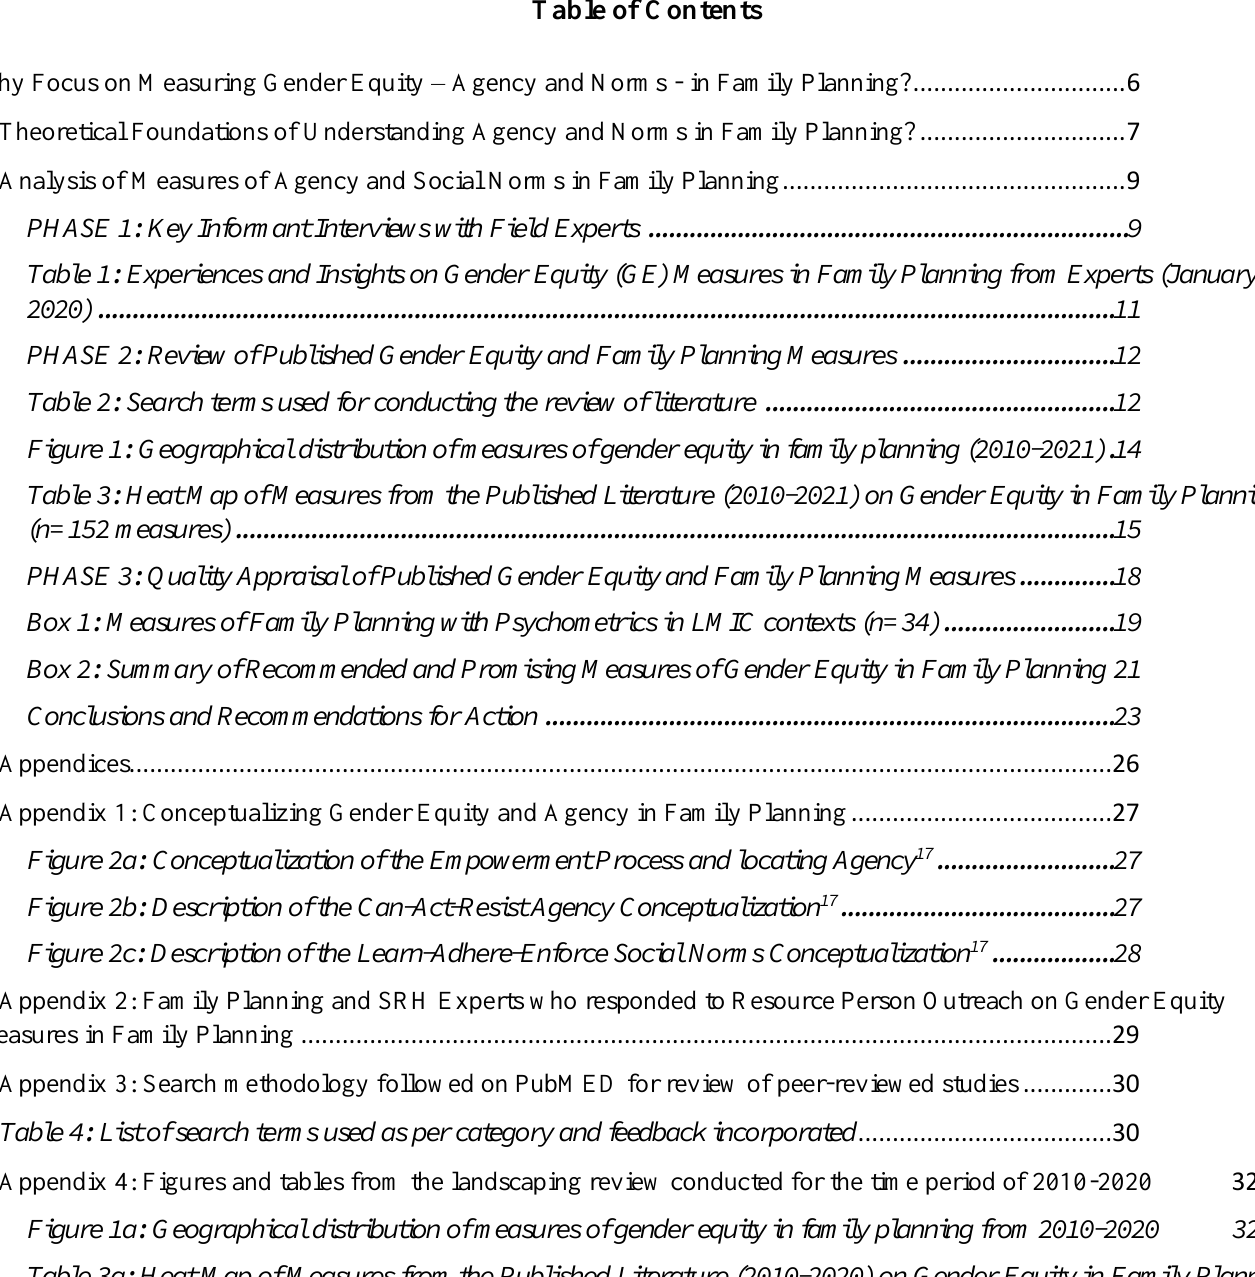
Table 5: Full list of gender equity measures in family planning in the White Paper (n=152)............